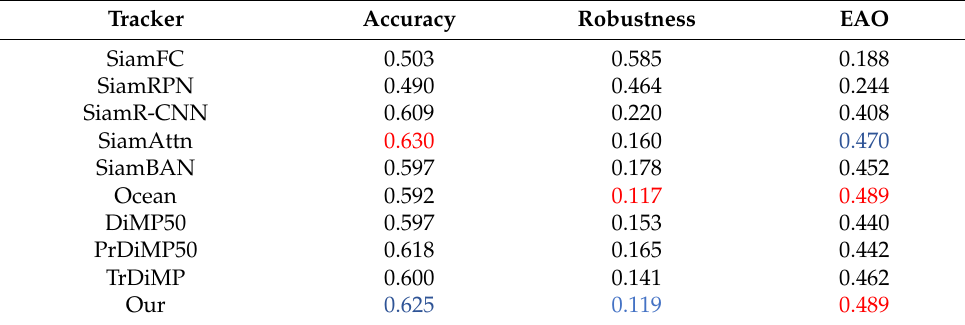
Table 1. EAO score ranking of trackers tested at